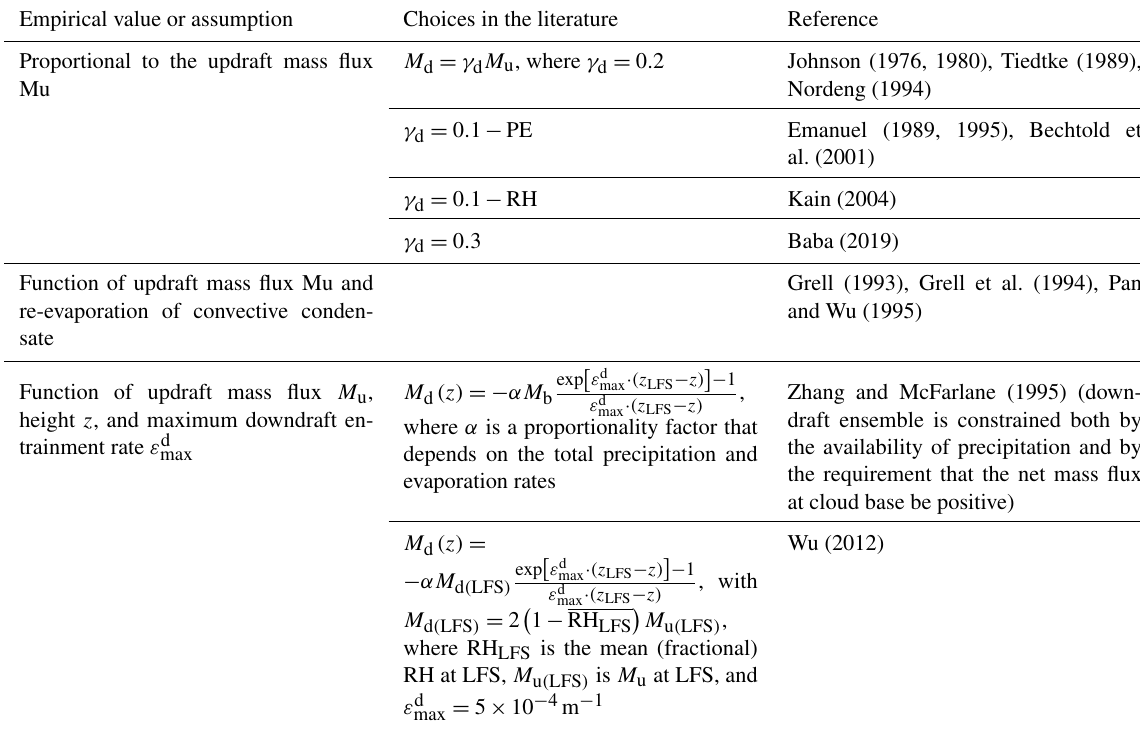
Table 14. A sample of empirical values and assumptions used in the closure in the downdraft. Empirical value or assumption Choices in the literature Reference M d = γ d M u , where γ d = 0 . 2 Proportional to the updraft mass flux Mu